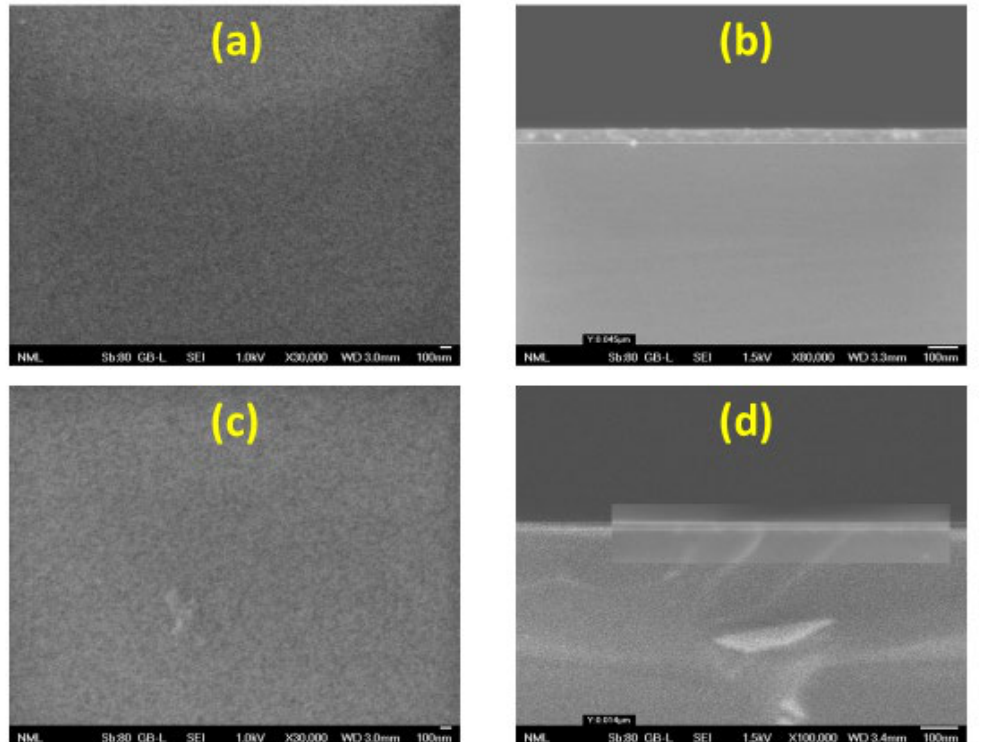
Figure 8. The SEM images for SnO 2 fabricated with ethanol via the sol–gel/spin-coating method: ( a ) the surface morphology for a 1000 rpm spin coating, ( b ) a cross-sectional image for a 1000 rpm spin coating, ( c ) the surface morphology for a 3000 rpm spin coating and ( d ) a cross-sectional image for a 3000 rpm spin coating.